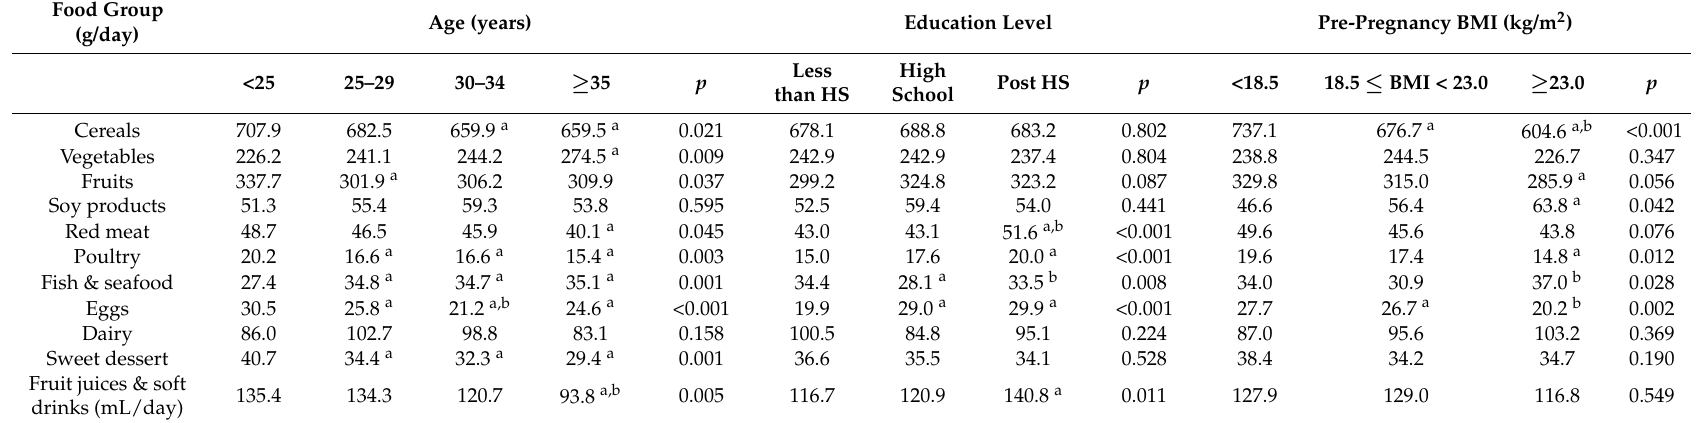
Table 3. Food intake by age group, education level, and pre-pregnancy BMI level among pregnant women in Vietnam,